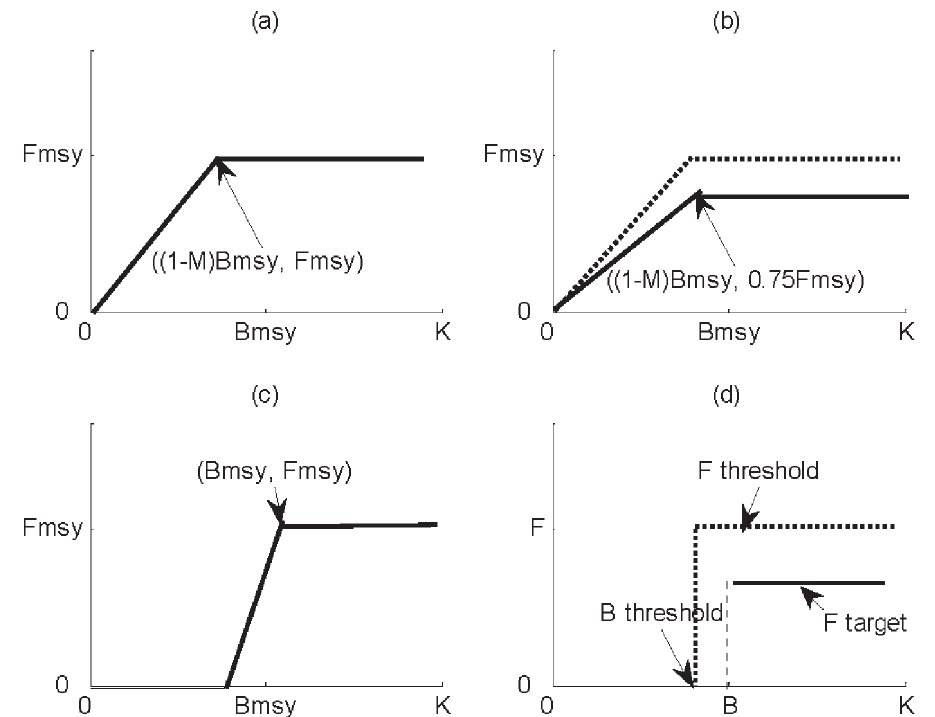
Fig . 1. – Examples of control rules used in fisheries management around the world: (a) south Atlantic black sea bass ( Centropristis striata ), (b) Atlantic shortfin squid ( Illex illecebrosus ), (c) Antarctic whales, and (d) Atlantic weakfish ( Cynoscion regalis